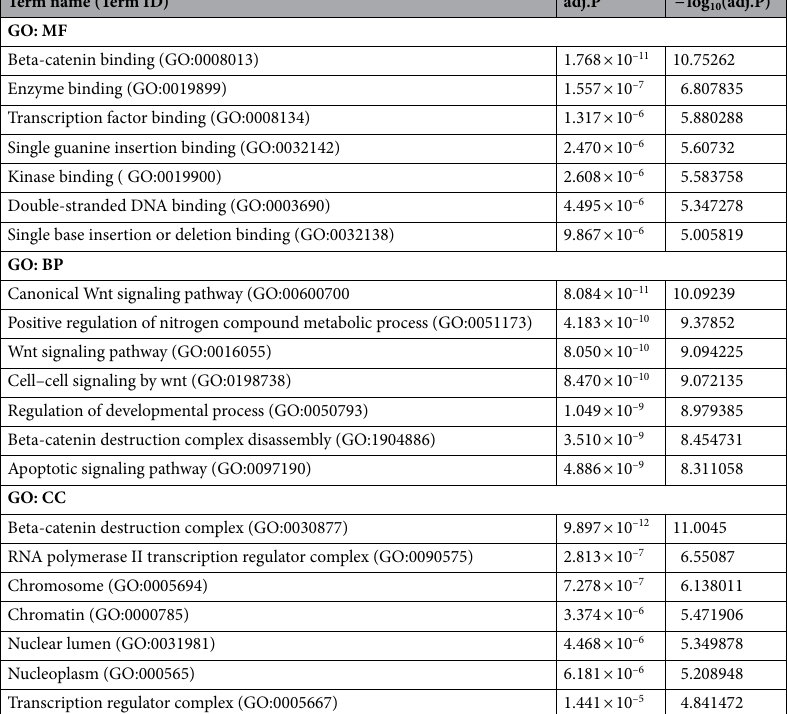
Table 7. GO (Gene Ontology) enrichment analysis for down-regulated